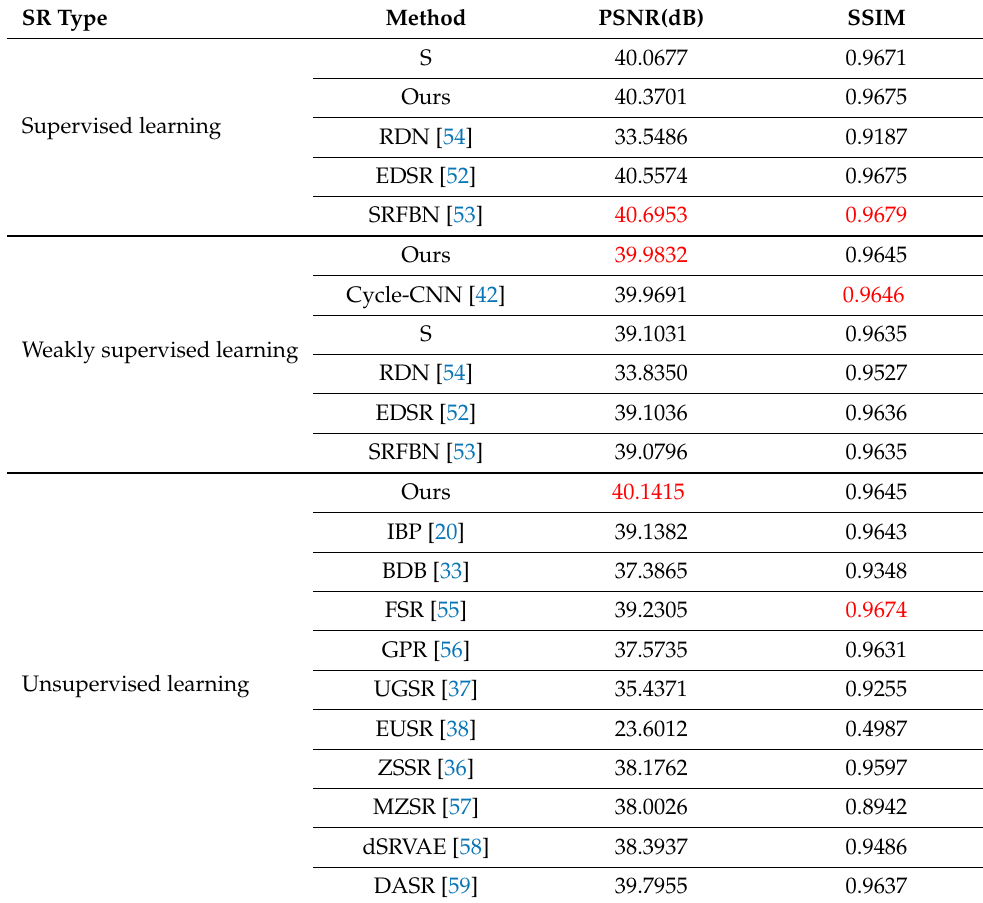
Table 6. Comparison between our method and other advanced SR algorithms on PROBA-V dataset. The best results are marked in red.